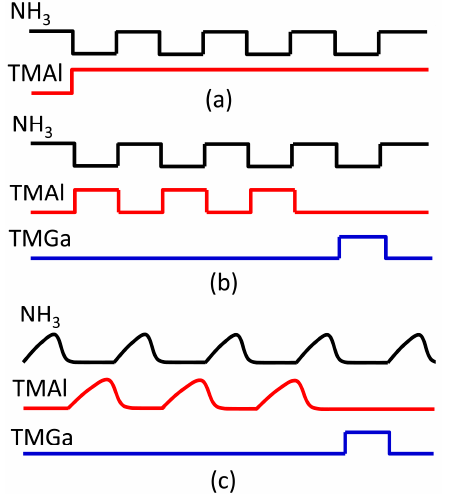
Figure 5. Representative gas flow sequences for ( a ) AlN growth by NH 3 pulse-flow method, AlGaN growth by ( b ) pulsed atomic layer epitaxy (PALE) and ( c ) migration-enhanced metal organic chemical vapor deposition (MEMOCVD) methods. Patterned after Reference [17,65,69].